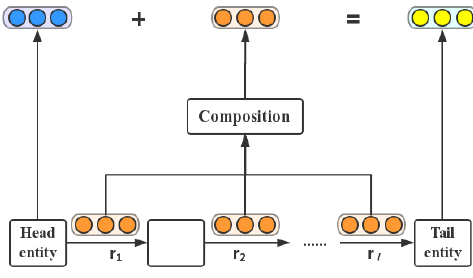
Figure 7. Framework of the PtransE